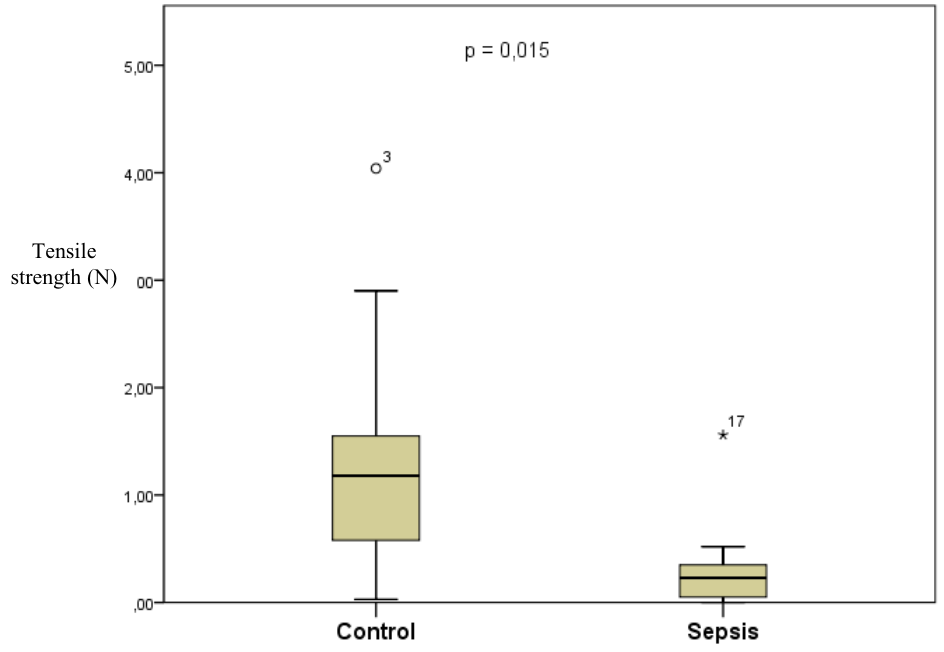
FIGURE 3 - Analysis of the breaking strength of animals euthanized on the 3 rd postoperative